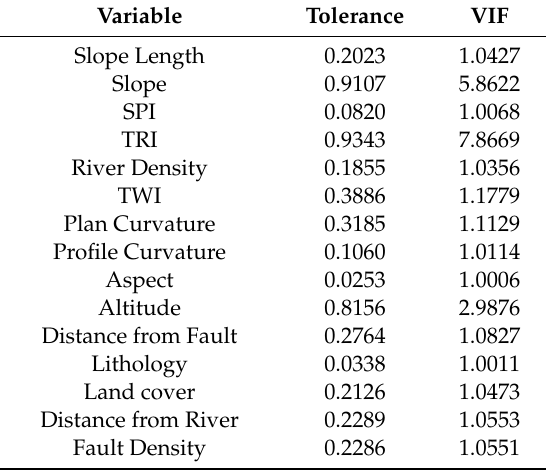
Table 2. Estimated VIF for each groundwater conditioning factor (multicollinearity). (VIFs greater than 5 or 10 or tolerance less than 0.1 indicate multicollinearity).